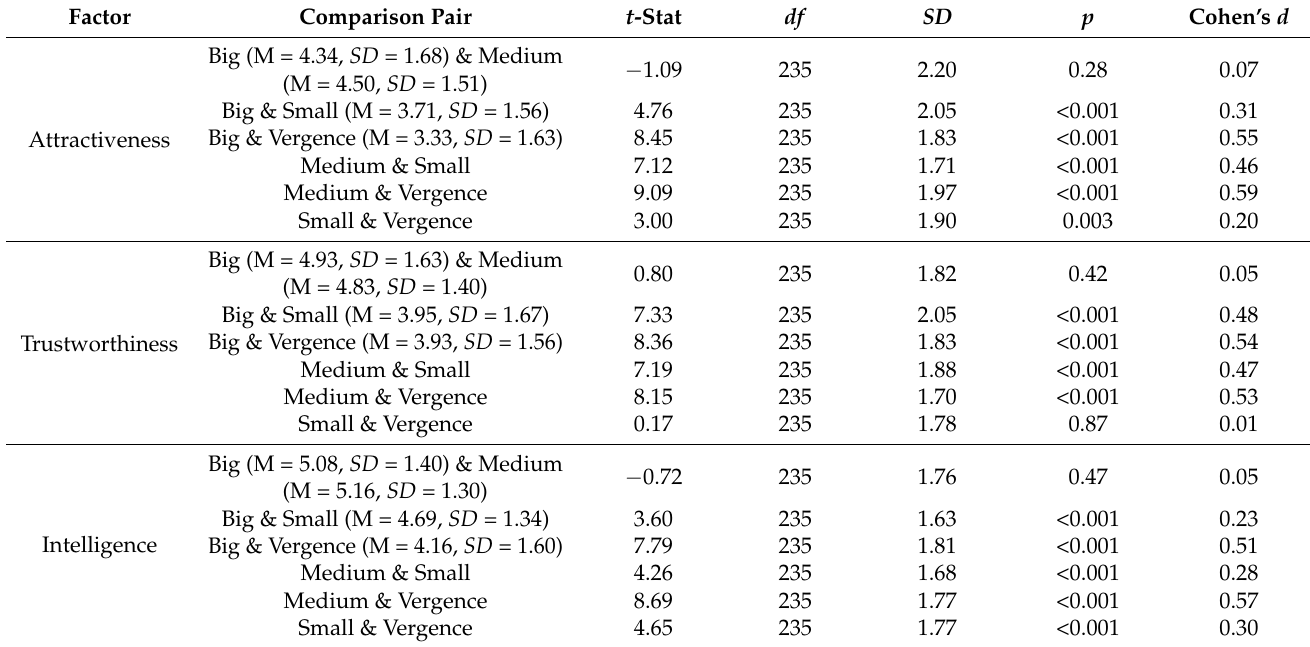
Table 1. Post-hoc comparisons for attractiveness, trustworthiness, and intelligence ratings in Experi- ment 1.